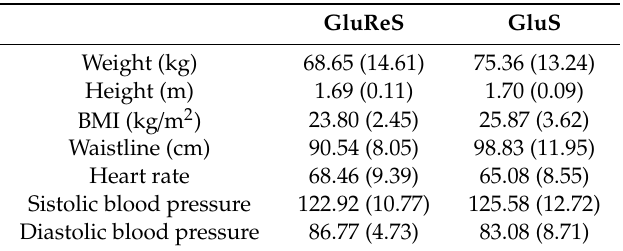
Table 1. Anthropometric data of the two groups.